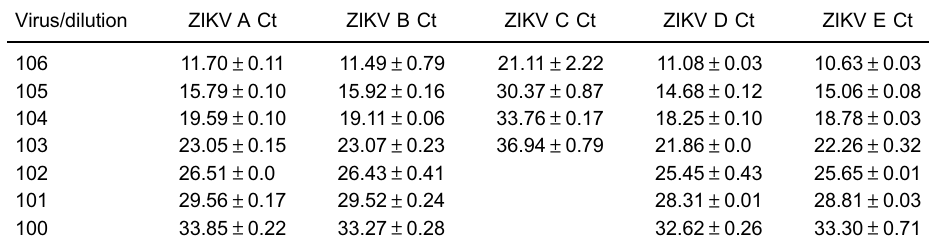
Table 1. Cycle threshold of primers/probes protocols used for all Zika virus (ZIKV) RNA dilutions.